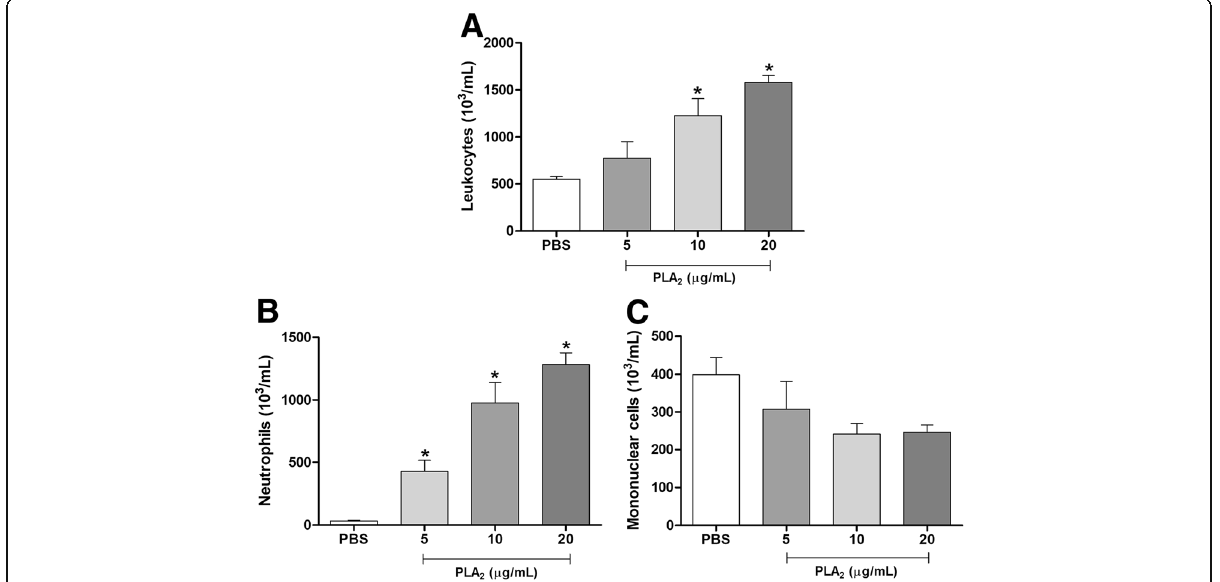
Fig. 7 Leukocyte recruitment induced by different concentrations of BJ-PLA 2 -I in mice. Migration of total leukocytes ( a ), neutrophils ( b ) and mononuclear cells ( c ) was evaluated at 4 h after the injection of BJ-PLA 2 -I (5, 10 or 20 μ g/mL) in the peritoneal cavity of mice. Control groups were injected only with PBS. Results were expressed as means ± SD ( n =5) of two independent experiments. * p <0.05 compared to the control group